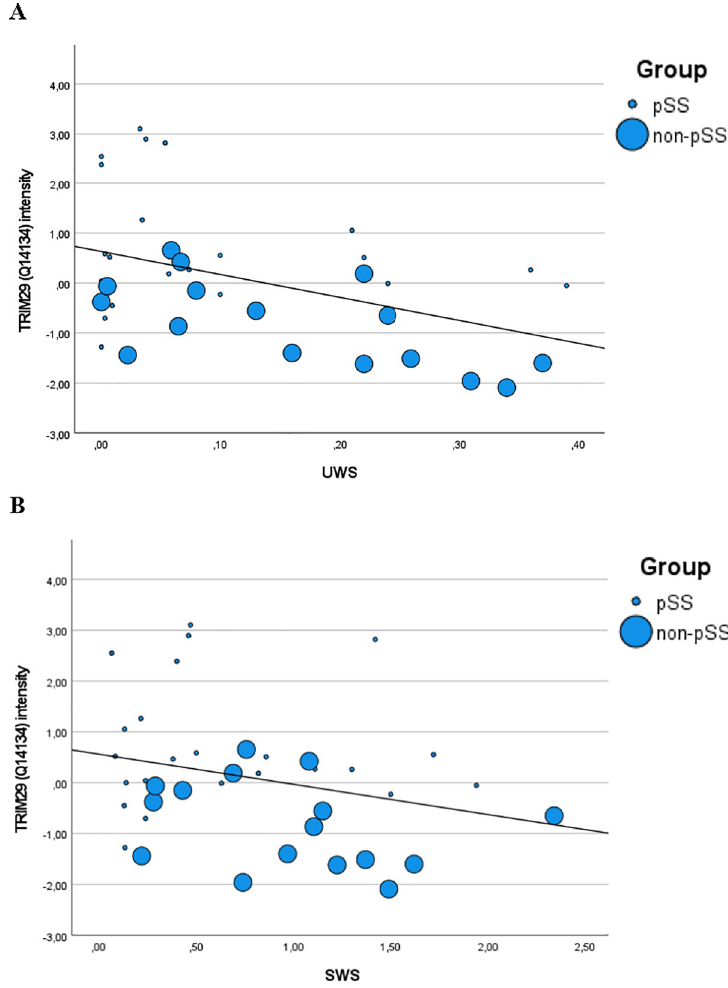
Fig 3. Correlation of salivary TRIM29 and saliva flow rates. Scatter plot illustrating the relation between salivary TRIM29 intensity and (A) unstimulated saliva flow rate (UWS) as well as (B) stimulated saliva flow rate (SWS). Small dots represent pSS patients and larger dots represent non-pSS patients. A weak, but statistically significant correlation ( p = 0.024) was observed between TRIM29 and UWS, but not between TRIM29 and SWS.